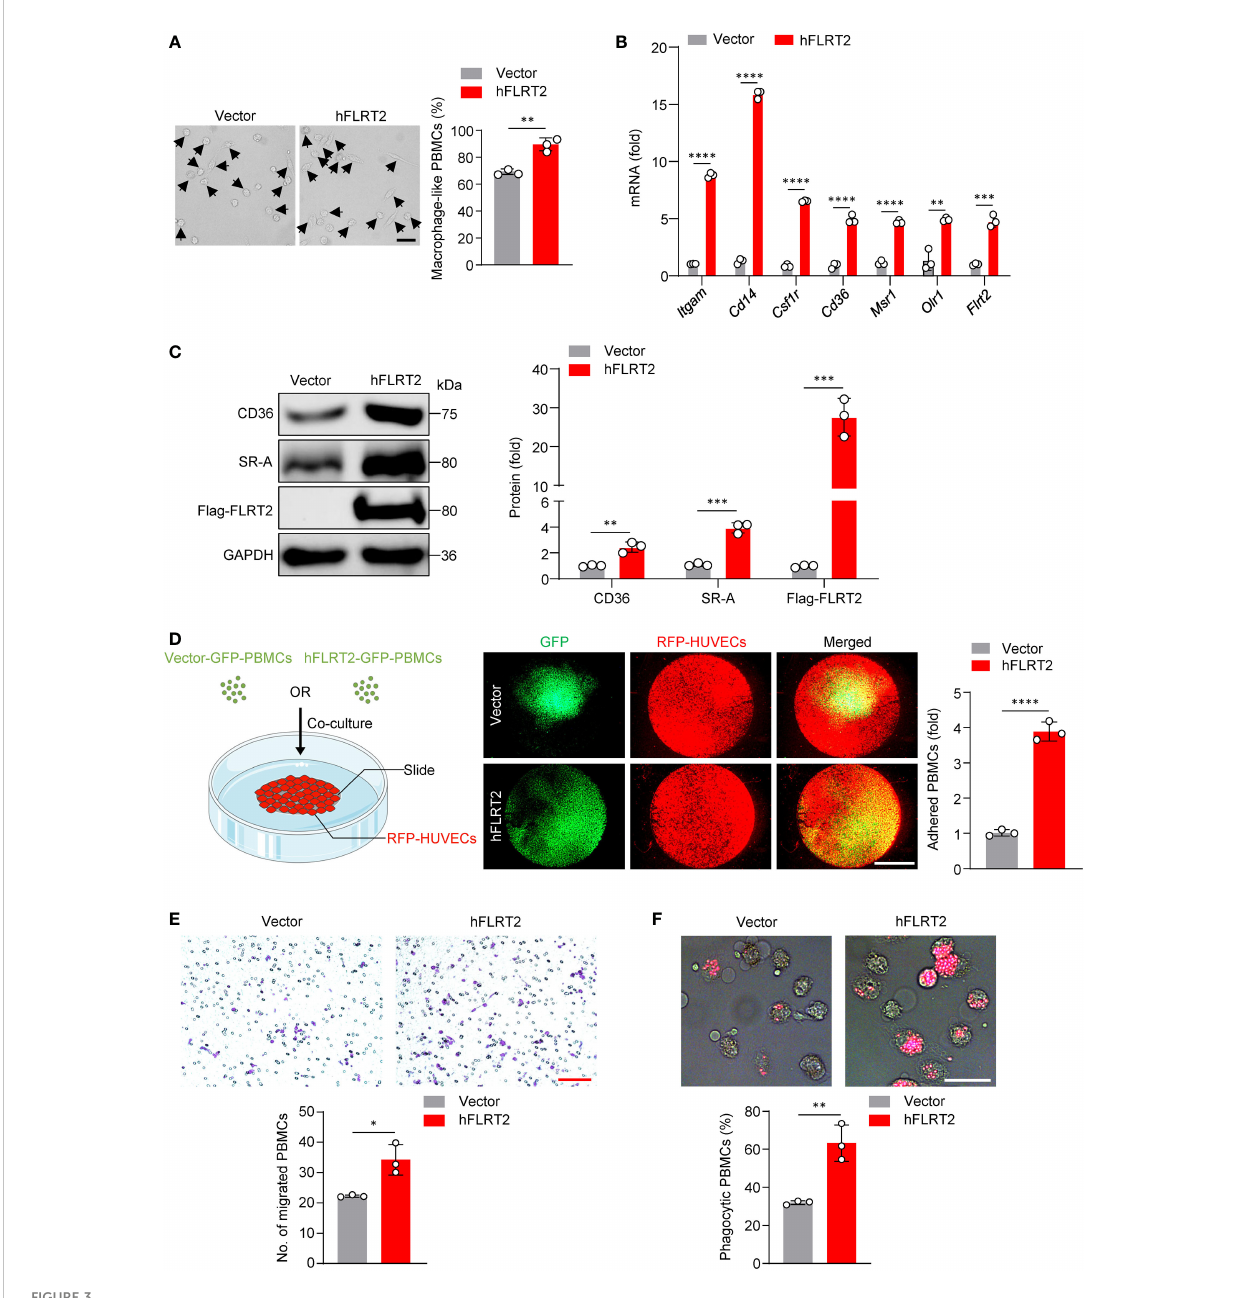
FIGURE 3 FLRT2 induces PBMC differentiation into macrophages and enhances the adhesion, migration, and phagocytosis of M-CSF-primed PBMC-derived macrophages. (A – C, E, F) Human PBMCs were transfected with control or hFLRT2 vector for 48 h. (A) Representative phase-contrast light microscopy images showing morphological alterations of PBMCs transfected as indicated (n = 3). Scale bar, 50 m m. (B) qPCR analysis of Itgam , Cd14 , Csf1r , Cd36 , Msr1 , Olr1 , and Flrt2 mRNA in PBMCs cells transfected as indicated (n = 3). (C) Immunoblot analysis of CD36, SR-A, and Flag- FLRT2 proteins in PBMCs transfected as indicated (n = 3). (D) HUVECs expressing RFP were co-cultured with PBMCs expressing vector-GFP or hFLRT2-GFP. After 6 h co-culture, pictures were taken using a fl uorescence microscope (n = 3). Scale bar, 5 mm. (E) Transwell cell migration assays were performed, and numbers of migrated cells were counted (n = 3). Scale bar, 100 m m. (F) Phagocytosis assays were performed by culturing the cells in Texas red-conjugated zymosan particles for 2 h at 37°C (n = 3). Cells were viewed for internalization of the particles by fl